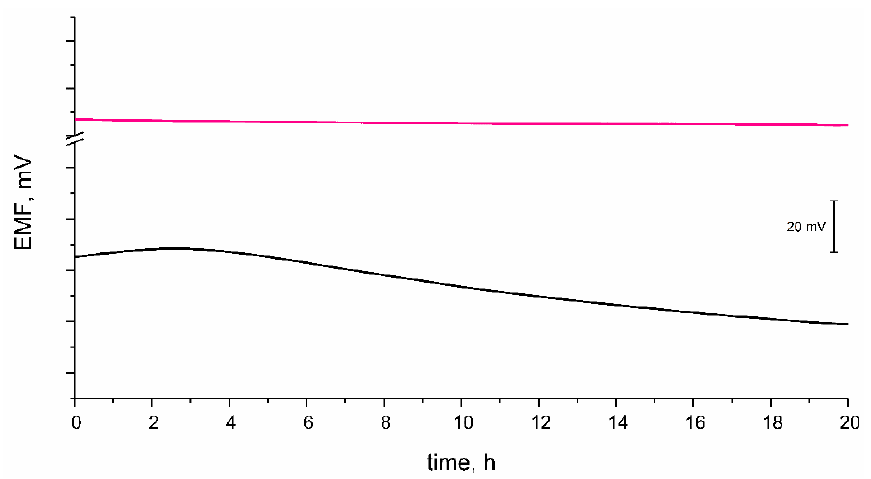
Figure 6. Stability of potential presented as potential change in time for one electrode representing each tested group. GC/RuO 2 + PEDOT:PSS(THF)/K + -ISM (pink line), GC/K + -ISM (black line).